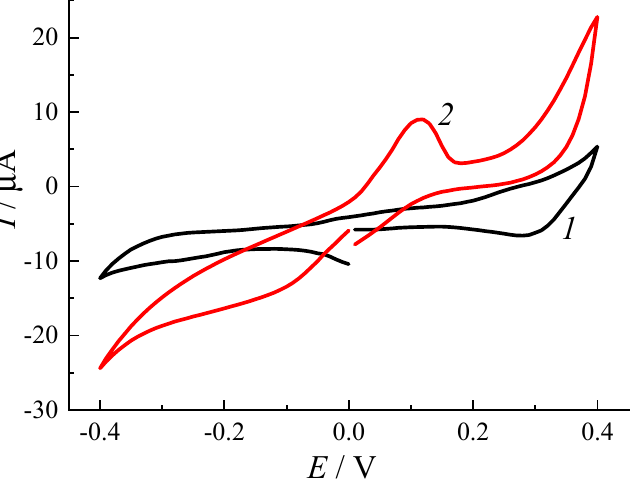
Figure 12. CV curves obtained at 20 mV/s from SPE/TiO 2 modified by 3 µL CuI-PPy (drop coating) in buffer (1) and 250 ppm of glutaraldehyde (GLU) solution (2) at pH 8.